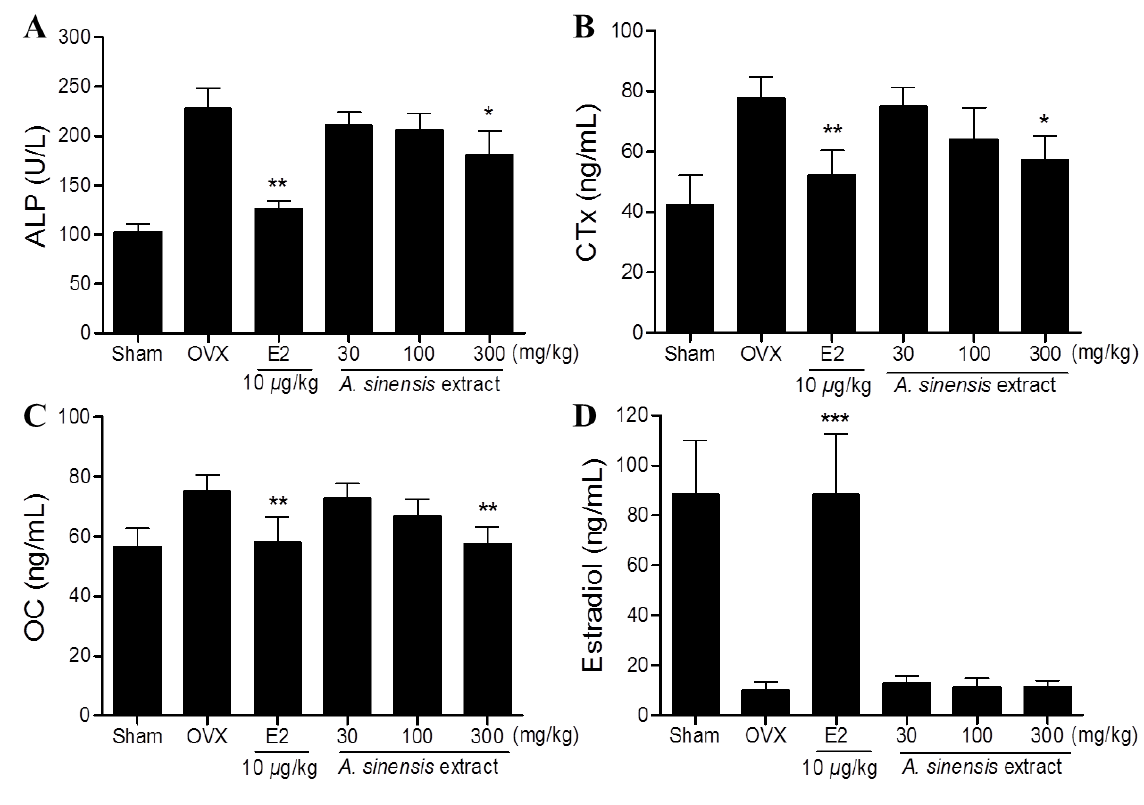
Figure 3. Effects of A. sinensis extract on serum alkaline phosphatase (ALP) ( A ); collagen type I C-telopeptide (CTx) ( B ); osteocalcin (OC) ( C ); and estradiol ( D ) concentrations in OVX